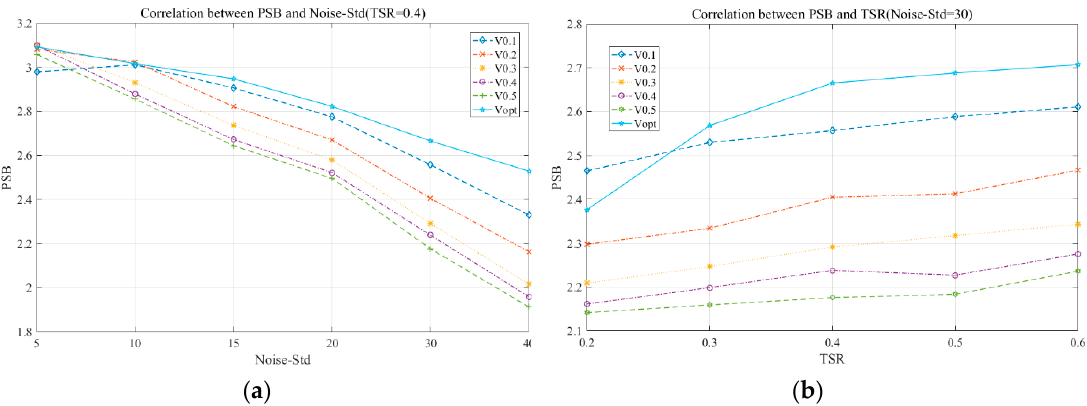
Figure 7. The correlation between the PSB, Noise-std, and TSR under the six different iteration stop conditions of Lena: ( a ) PSB changes with Noise-std, ( b ) PSB changes with TSR.